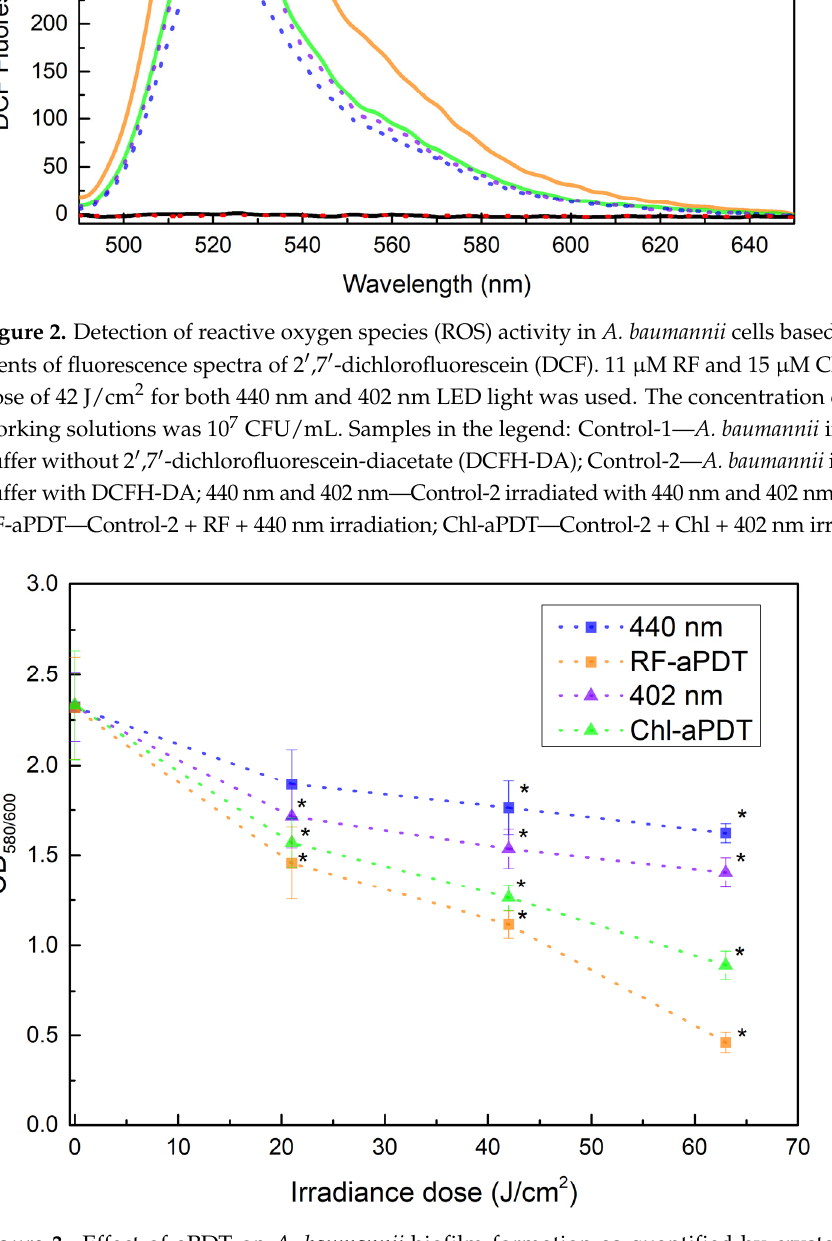
Figure 3. Effect of aPDT on A. baumannii biofilm formation as quantified by crystal violet (CV) assay. 440 nm and 402 nm—bacteria irradiated without PS; RF-aPDT—bacteria with 11 µM RF; Chl-aPDT—bacteria with 15 µM Chl. Every point is the average of OD 580/600 ratio of three independent experiments, error bars indicate standard deviation; * indicates statistical significance compared to control culture, p < 0.05.